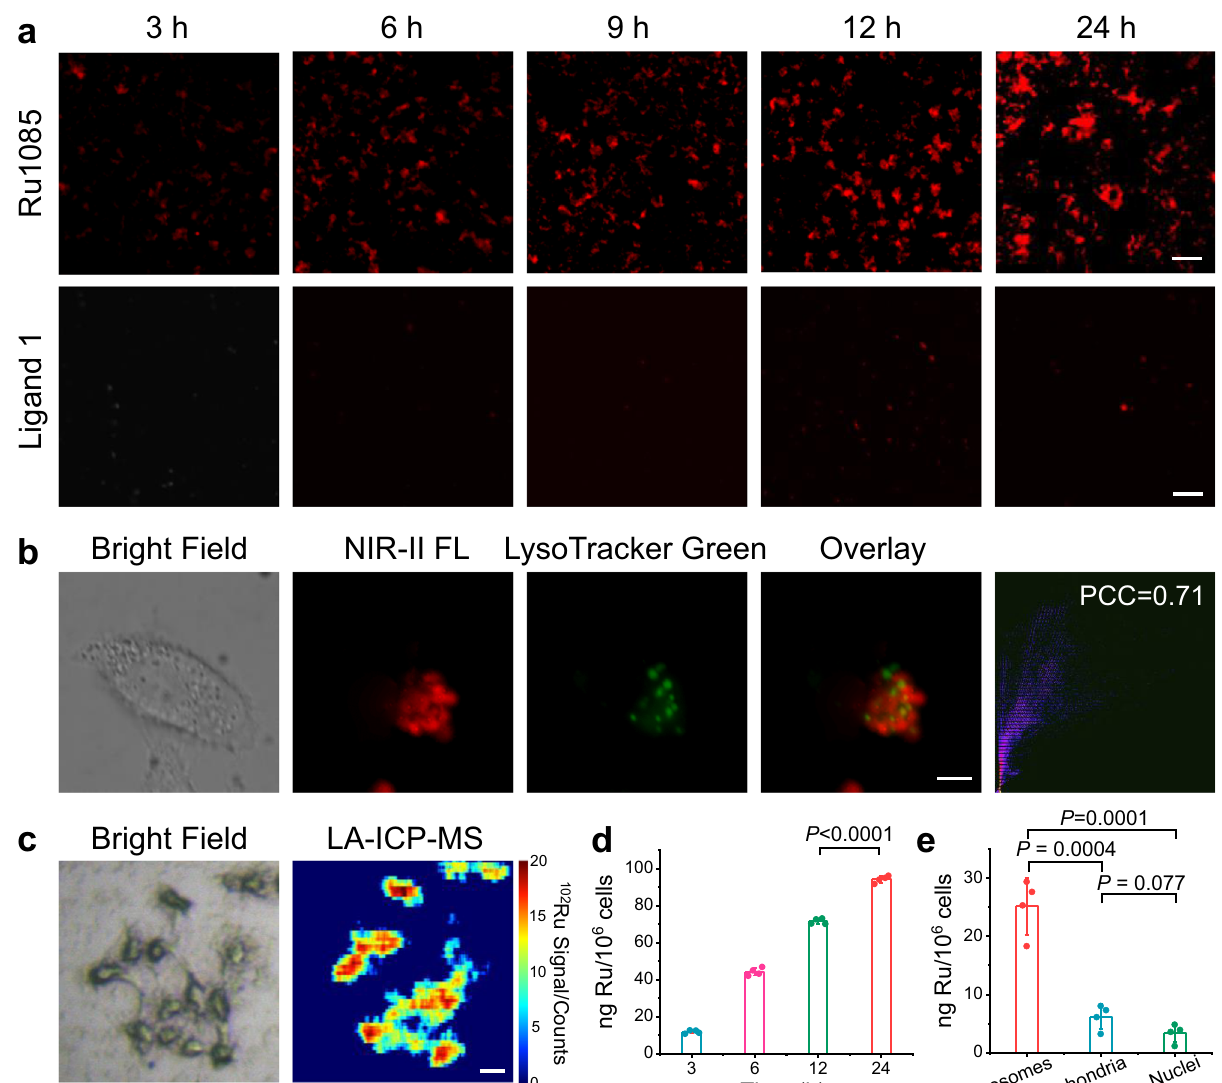
Fig. 4 Cellular uptake and localization of Ru1085 in A549 cells. a NIR-II fl uorescence images of cells incubated with Ru1085 (10 µ M) and ligand 1 (20 µ M) over time. Scale bar, 50 µ m. b Colocalization assay of Ru1085 (10 µ M) using LysoTracker Green as lysosomal dye. The PCC was calculated to be 0.71. Scale bar, 5 µ m. c LA-ICP-MS imaging of 102 Ru in cells after incubated with Ru1085 (5 µ M). Scale bar, 20 µ m. ICP-MS results of d intracellular Ru amount with time-dependence and e Ru localization after incubated with Ru1085 (5 µ M) for 6 h. Data were presented as mean ± s.d. ( n = 4). Statistical differences were analyzed by Student ’ s two-sided t -test. Source data are provided in Source Data fi